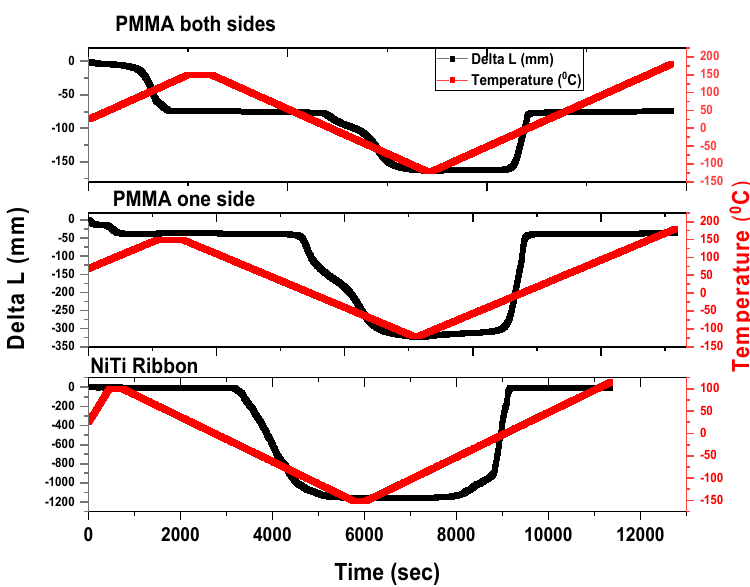
Figure 6. Displacement as a function of time and temperature for the Ni-Ti ribbon and PMMA composite.